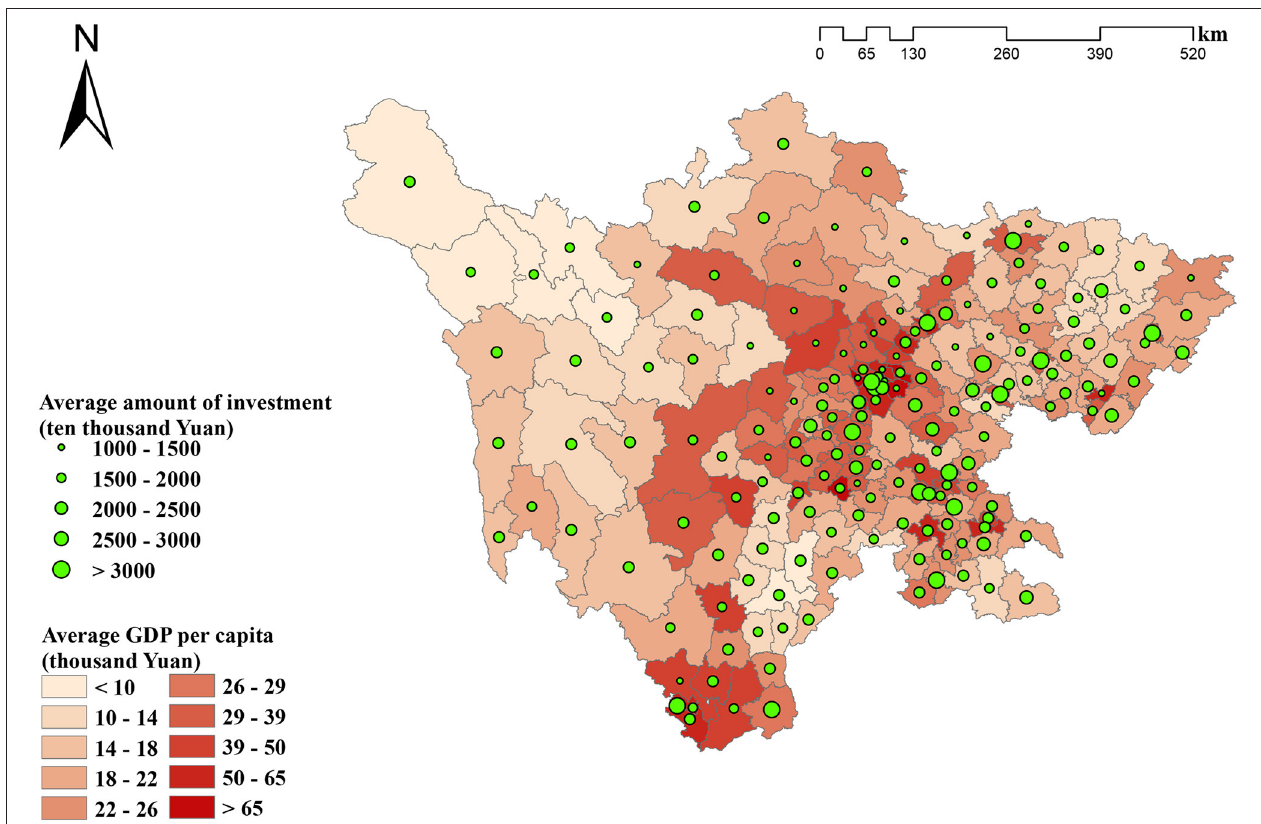
FIGURE 3 | The distribution of average amount of provincial and central governments investment among counties from 2009 to